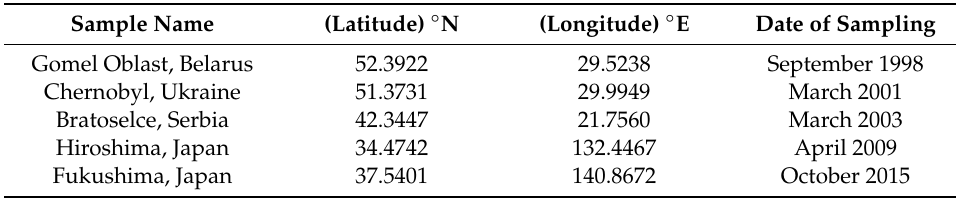
Table 3. Details of sampling locations and dates.